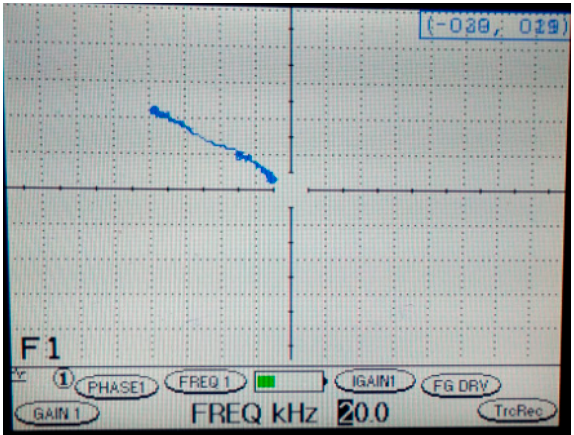
Figure 9. Commercial differential probe Measuring. Table 3. Differential and Absolute Probe Measuring.